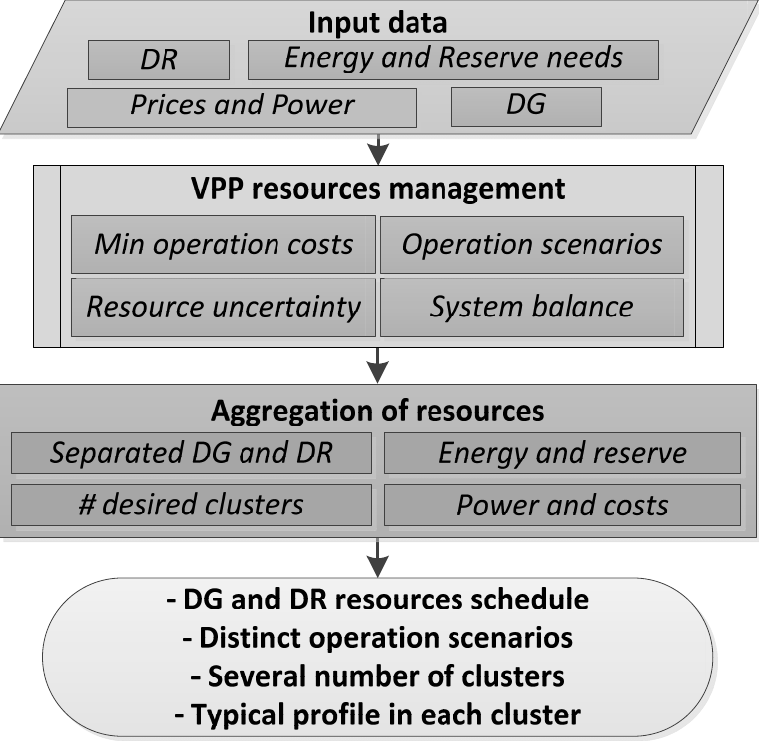
Figure 3. Diagram of the proposed resources aggregation